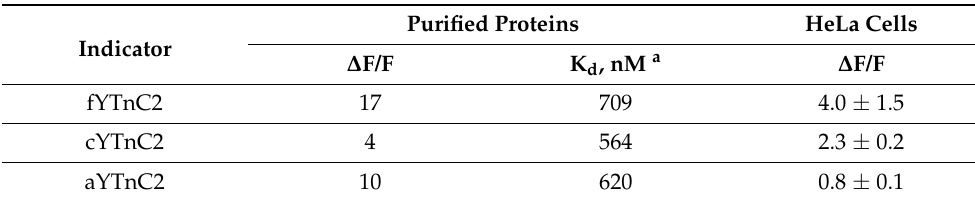
Table 3. Properties of fYTnC2, cYTnC2, and aYTnC2 mutants. a Kd was measured in buffer containing 1 mM MgCl 2